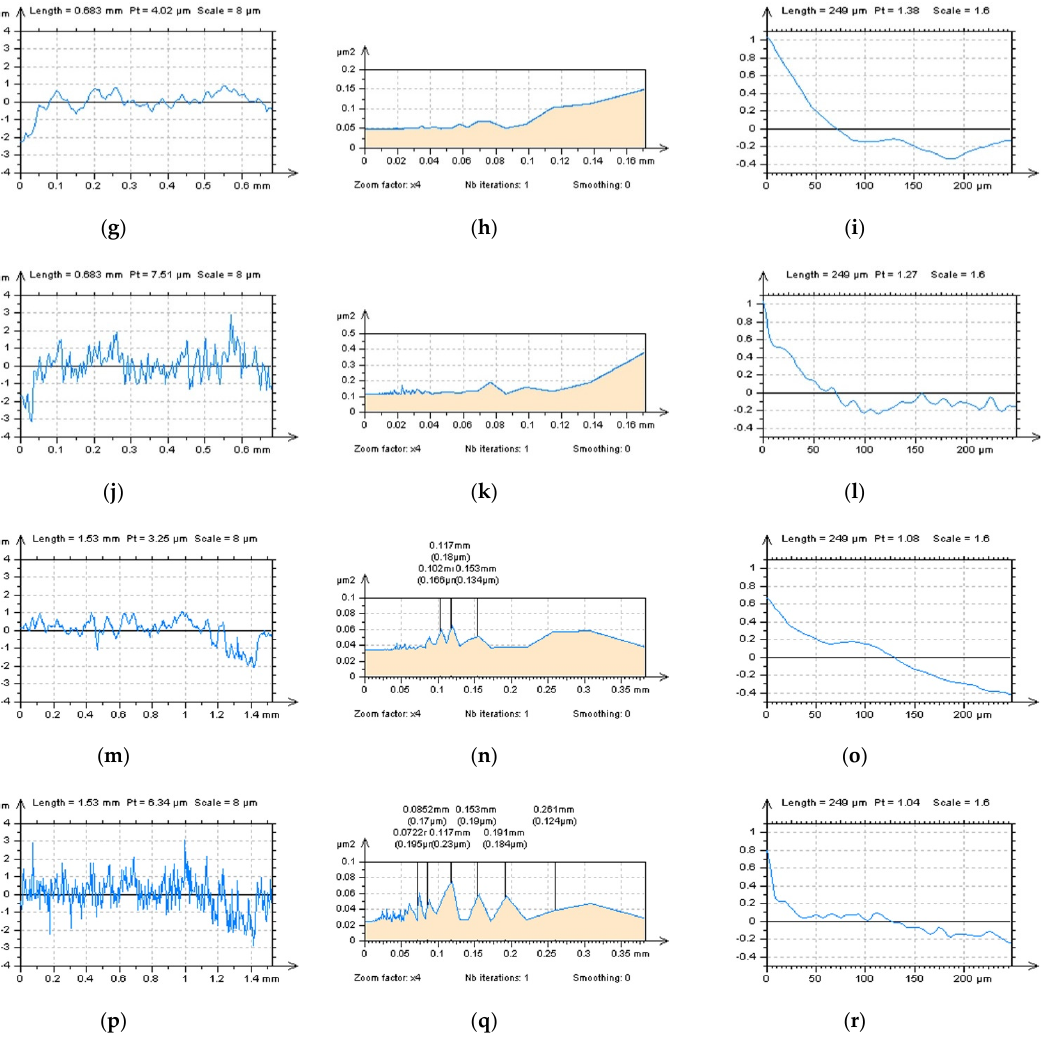
Figure 4. Extracted profiles ( left ), their PSDs ( middle ) and ACFs ( right column) of the LST detail: measured ( a – c ) and with high ‐ frequency errors ( d – f ) and, respectively, after an application of thresholding method ( g – r ).